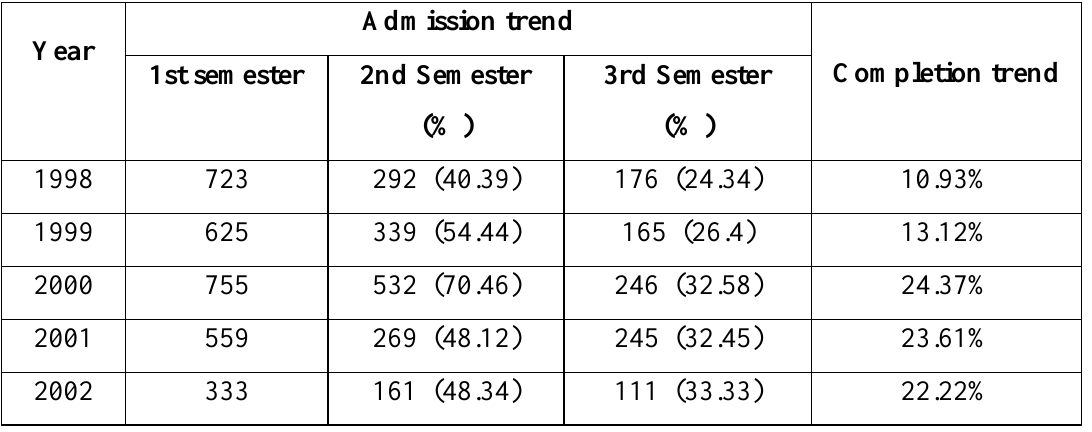
Admission and Registration Pattern of DCSA